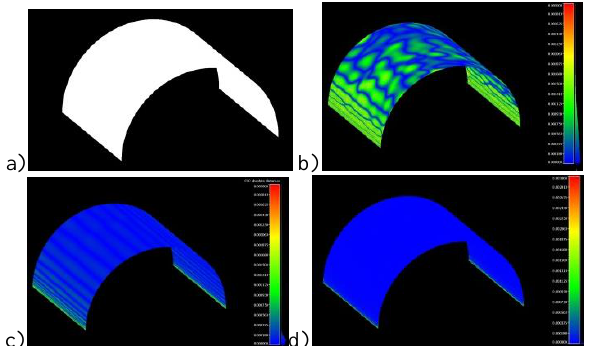
Fig. 8. Results for a synthetic barrel vault with a 10 neuron into each layer: (a) original point cloud; (b) result with 3 layers; (c) results with 5 layers; and (c) results with 7 layers (color scale is the same for images b-c-d).